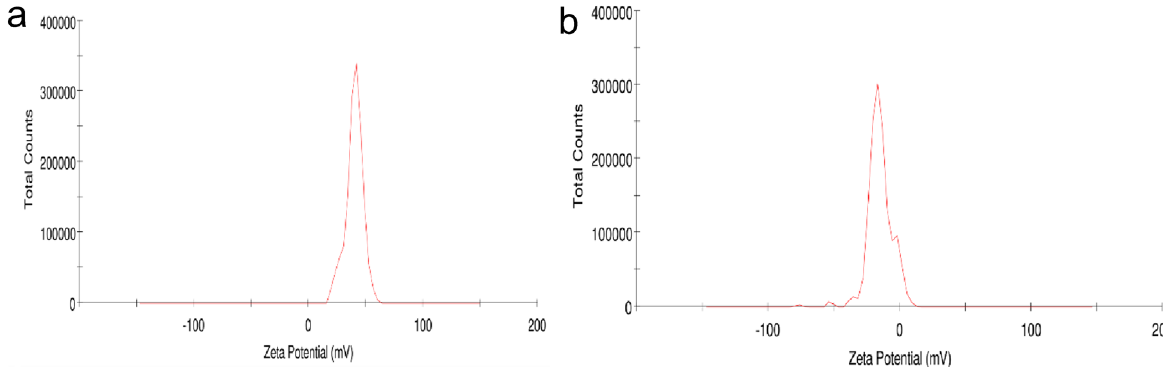
Figure 5. Zeta potential analysis of ( a ) SPIONs; ( b ) Latex coated SPIONs.